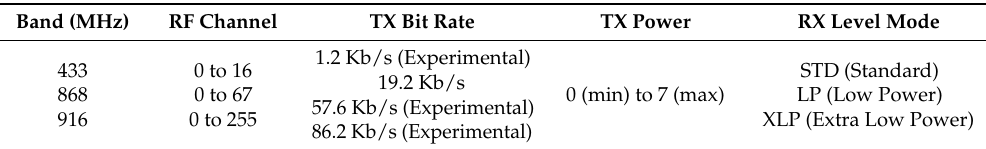
Table 1. Configuration parameters of the IQRF network.